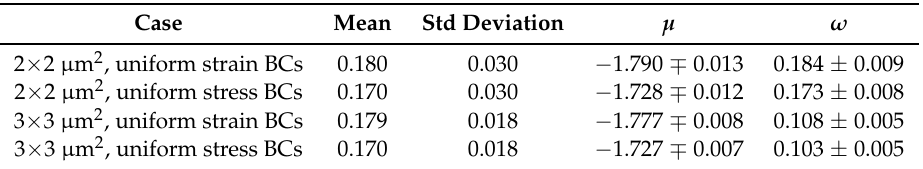
Table 3. Poisson’s ratio ν : apparent values of the mean and standard deviation obtained with the MC analysis and parameters for the lognormal CDFs in Equation